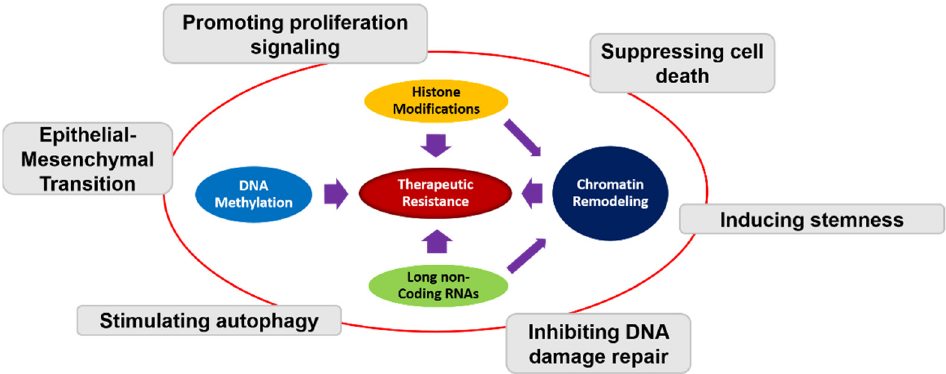
Figure 1. Schematic representation of the interplay between different epigenetic mechanisms and therapeutic resistance in GBM. DNA methylation, histone modifications, chromatin remodeling, and long non-coding RNAs all contribute to therapeutic resistance through different mechanism including promoting proliferation, suppressing cell death, inducing stemness, inhibiting DNA damage repair, stimulating autophagy, and epithelial–mesenchymal transition (EMT).